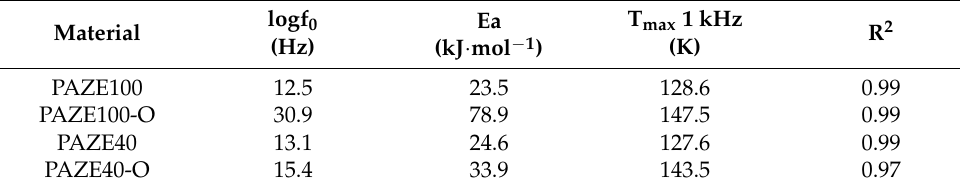
Table 2. Apparent activation energies and Tmax of the γ relaxations of oriented and unoriented PAZE100 and PAZE40, as obtained by the fitting of the Arrhenius equation. Margins within 3% of standard